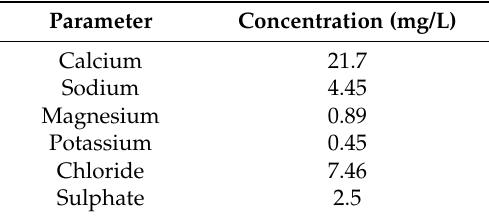
Table 2. Major constituents in the tap